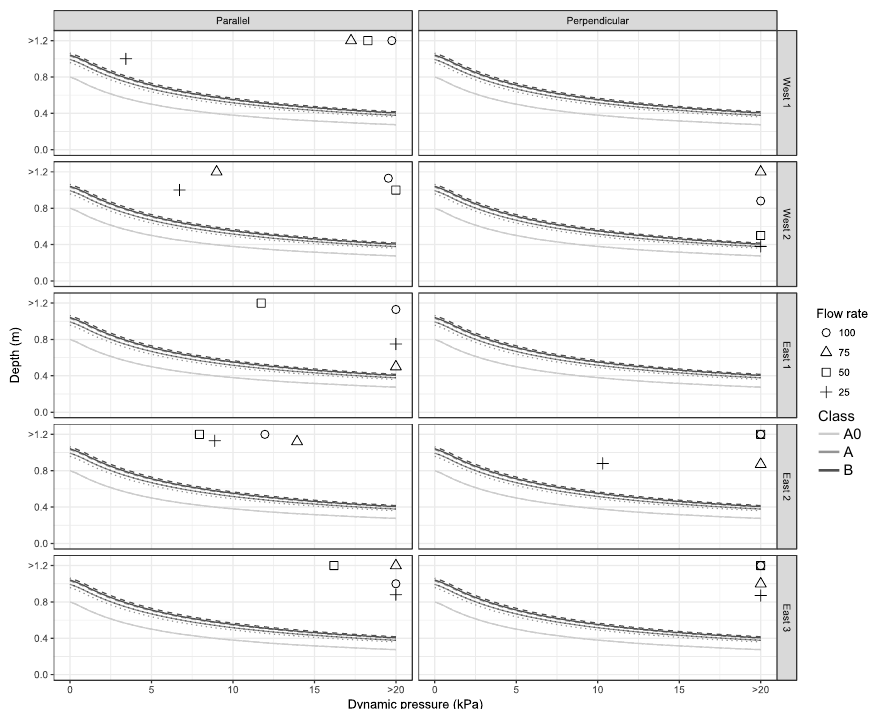
Figure 9. Critical depth–pressure curves for building classes A0, A and B subjected to Newtonian flow. Peak normal pressures and corre- sponding depths applied to each city block are plotted as points for each flow rate.